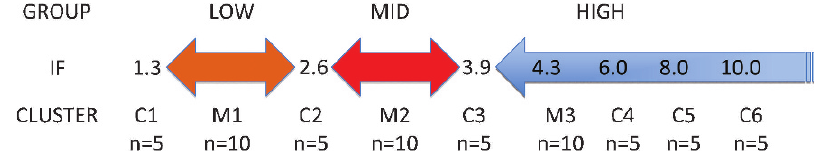
Figure 1 - Content of and mean Impact Factor (IF) of nine clusters containing 60 journals. Major clusters M1 and M2 are centrally placed with respect to groups LOW and MID, M3 adequately above the lower limit of group HIGH. Minor clusters C1, C2, C3 mark the limits of